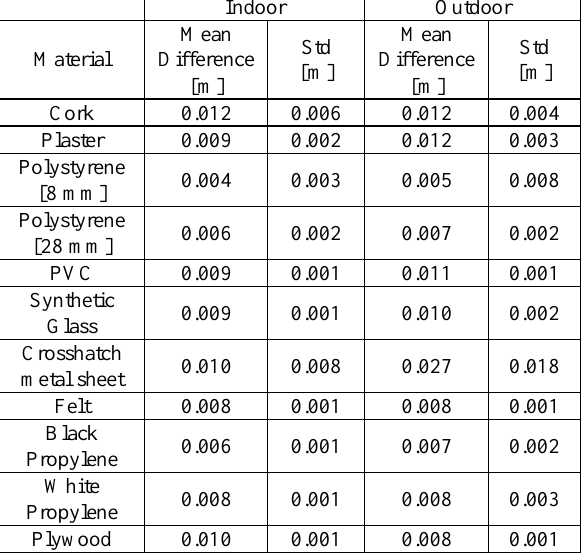
Table 4. Differences between the reference scan and the generated point clouds for each